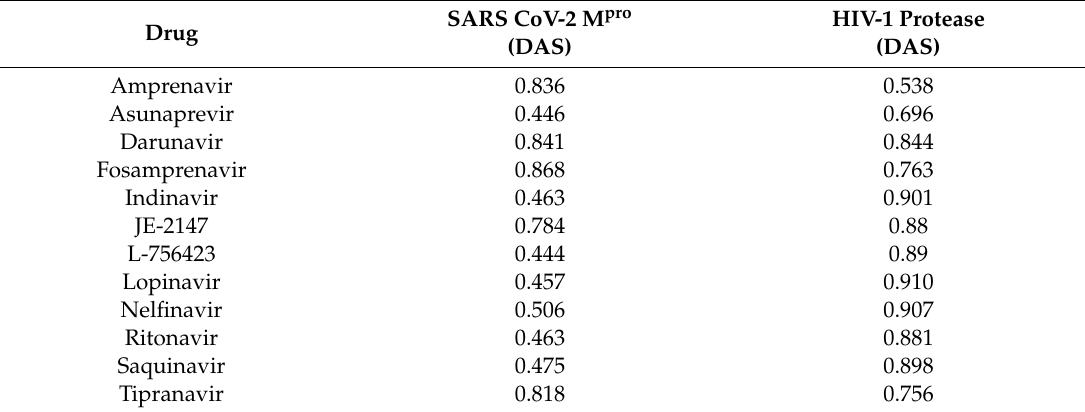
Table 3. Biotarget affinity scores (DAS) of known HIV inhibitors against COVID-19 M PRO and HIV-1 protease DRUDIT models.